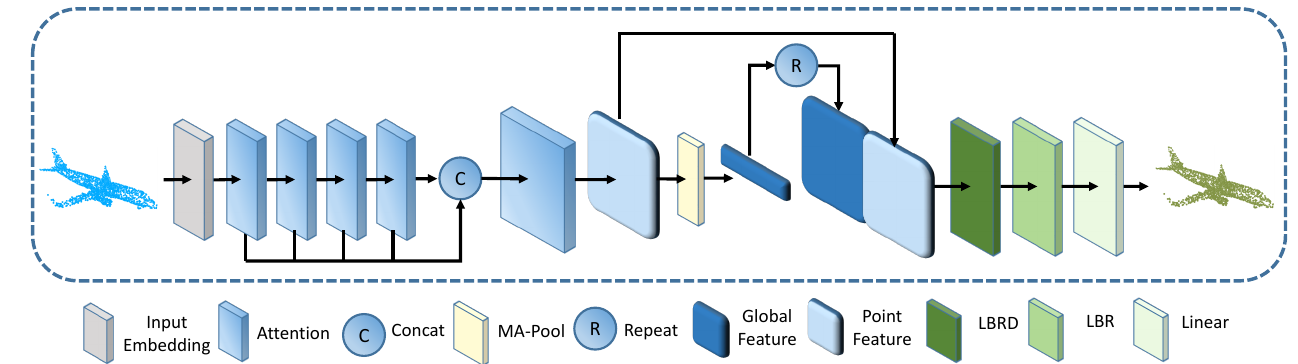
Figure 6. The architecture of PCT. The encoder consists of an input-embedding module and four stacked attention modules. The decoder comprises multiple linear layers. MA-Pool concatenates MP and AP. LBR combines Linear, BatchNorm and ReLU layers. LBRD means LBR followed by a Dropout